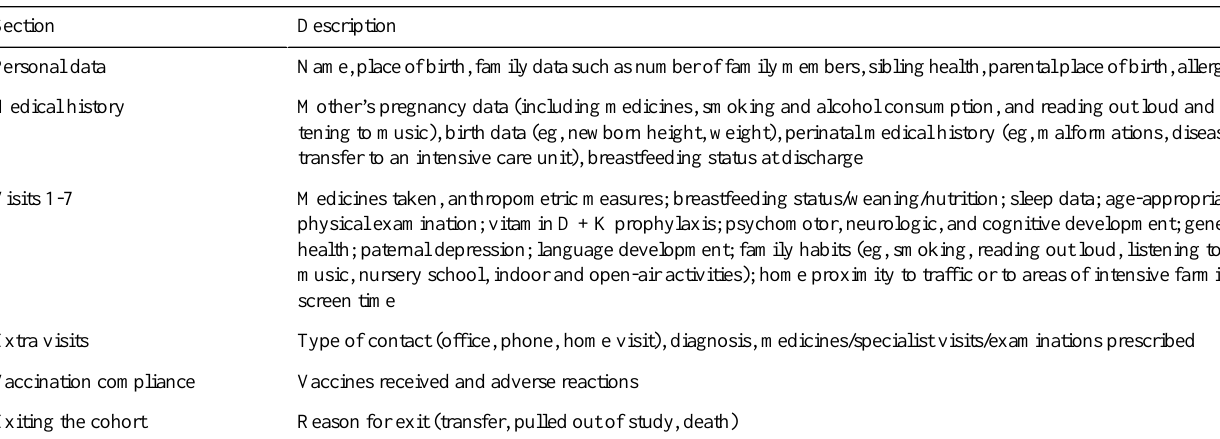
Table 1. Main sections of the online questionnaires and description of the general data collected.